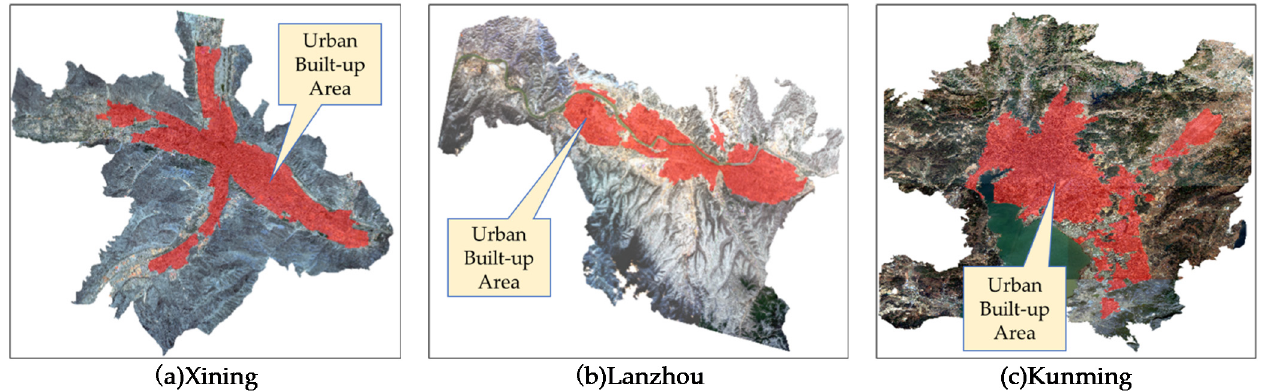
Figure 3. Examples of urban built-up areas extracted from remote sensing imagery: ( a ) urban built-up area of Xining; ( b ) urban built-up area of Lanzhou; ( c ) urban built-up area of Kunming. The satellite images we used were taken in the fourth quarter of 2015. The satellite (image resolution) and coverage percentages are as follows: WorldView-1/2 (0.5 m), ac- counting for 23.74%; Aerial images (0.5 m), accounting for 22.25%; ZY-3 (2.1 m), accounting for 19.65%; SPOT 6/7 (1.5 m), accounting for 17.74%; and Pleiades (0.5 m), accounting for